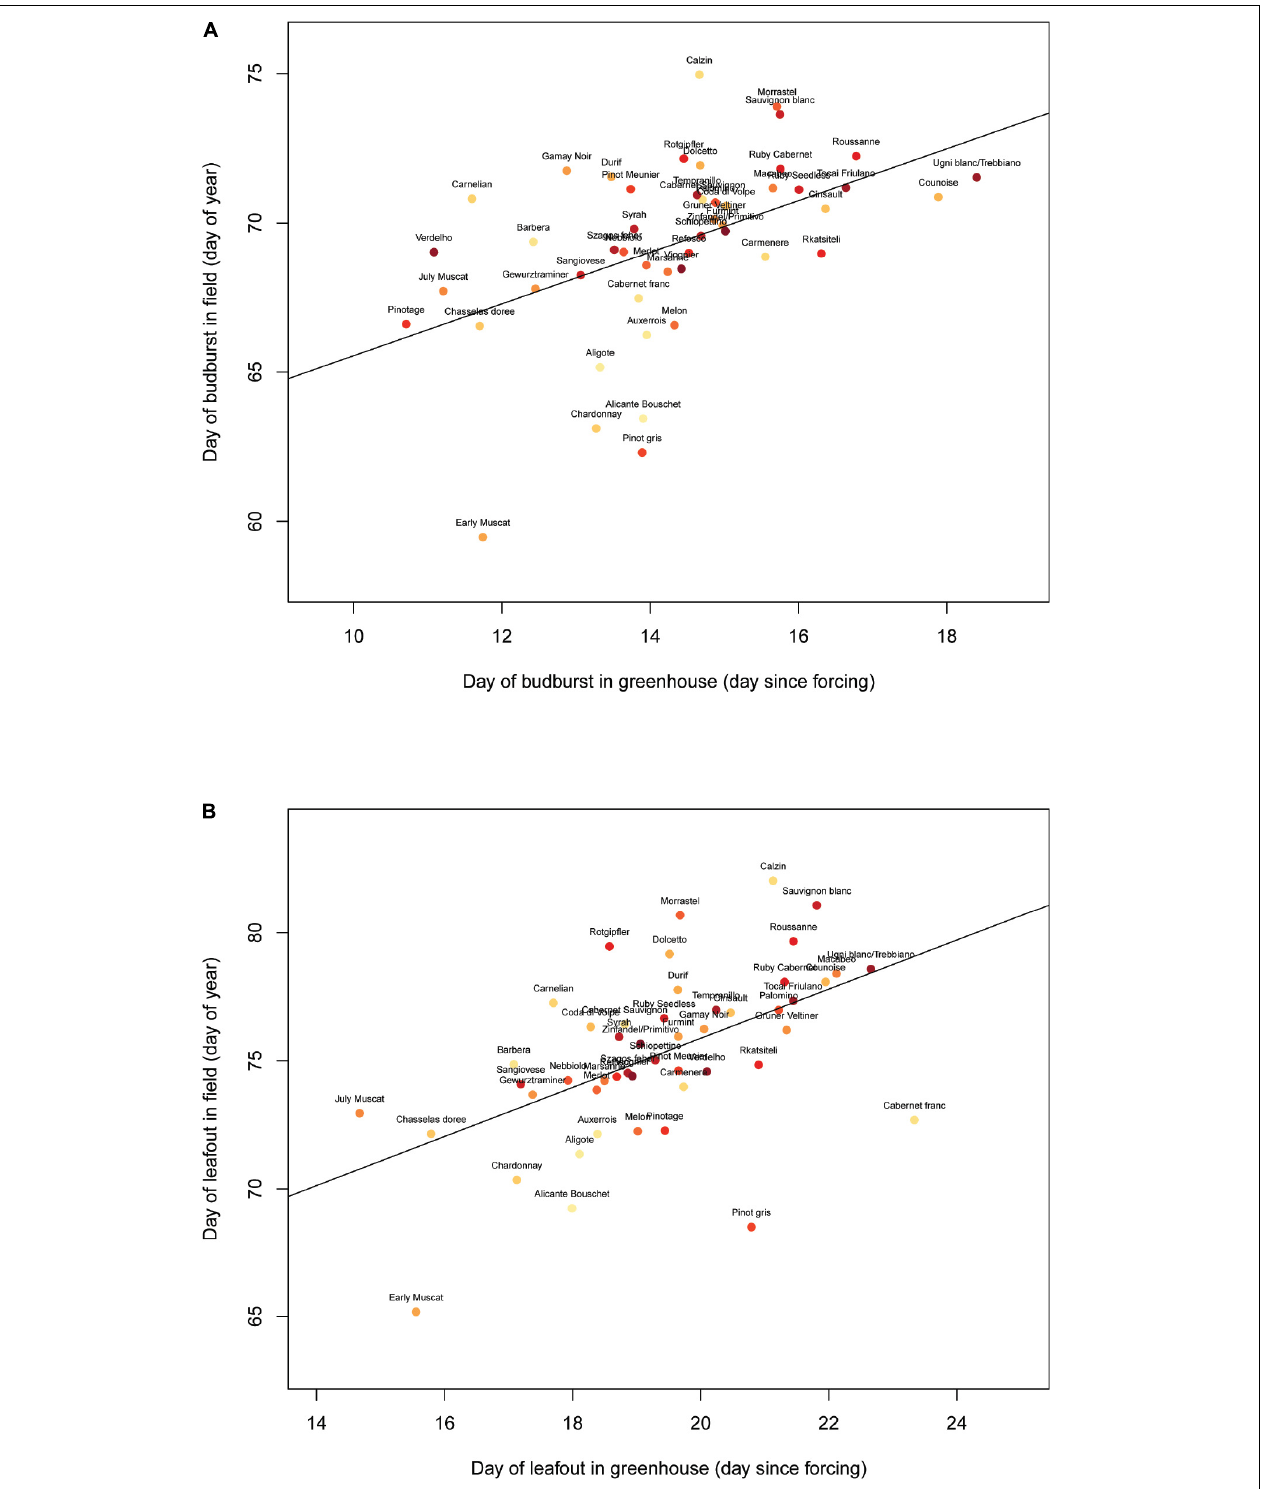
FIGURE 1 | Day of budburst (A) and leafout (B) in the Robert Mondavi Institute Vineyard (Davis, CA, United States) from the 2015 growing season correlates to the day of budburst ( F (1,47) = 14.55, p < 0.001) and leafout ( F (1,47) = 18.51, p < 0.001) in greenhouse conditions across 50 varieties (each point represents a different variety that was grown both in the vineyard and in the